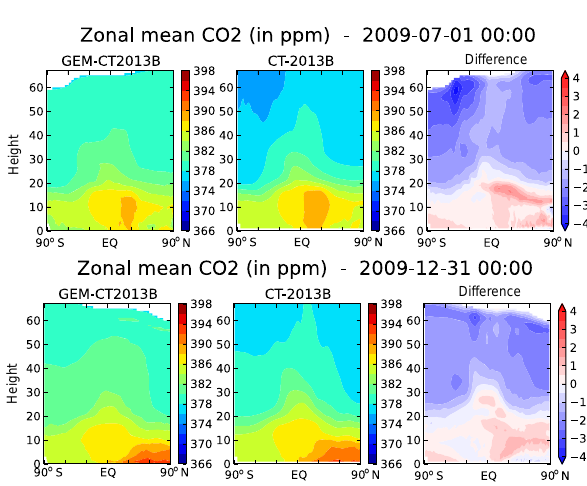
Figure 6. Zonal mean CO 2 on 1 July 2009 (top row) and 31 De- cember 2009 (bottom row) for GEM-MACH-GHG with CT2013B fluxes (left column), CT2013B (middle column) and CT2013B mi- nus GEM-MACH-GHG fields (right